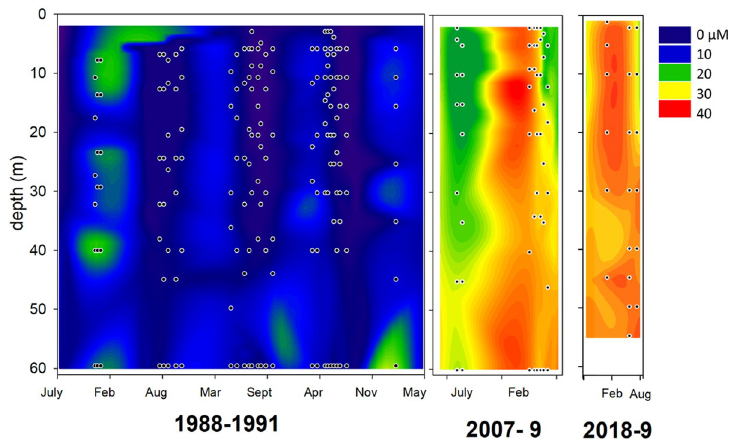
Fig 1. Dissolved silica concentrations (dSi) at Fox Point, Lake Michigan during the periods 1988–1991, 2007–2009 and 2018–9 through the top 60 m of the 100 m water column. Dots indicate sampling